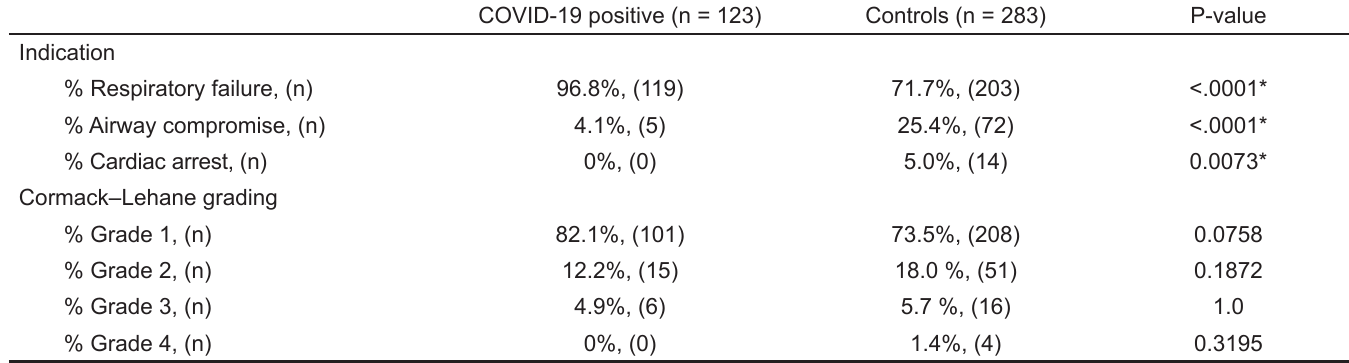
Table 1. Patient characteristics associated with COVID-19 compared with controls. Data presented as column percentages and raw number of annotated responses. An asterisk indicates where α < 0.05.